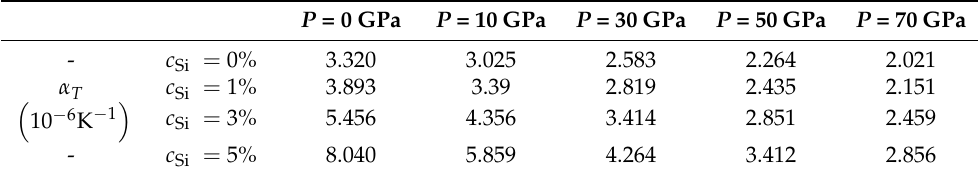
Table 4. Si concentration and pressure dependence of thermal expansion coefficient α T for WSi at T = 300